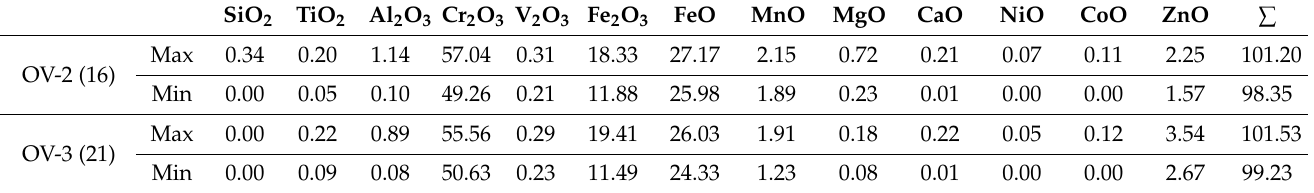
Table 2. Chemical composition of chromite (wt. %).